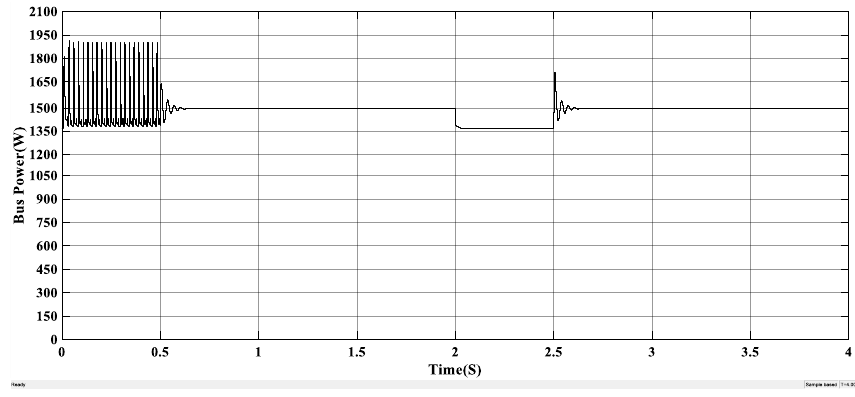
Figure 13. The DC bus power waveform in island operation.